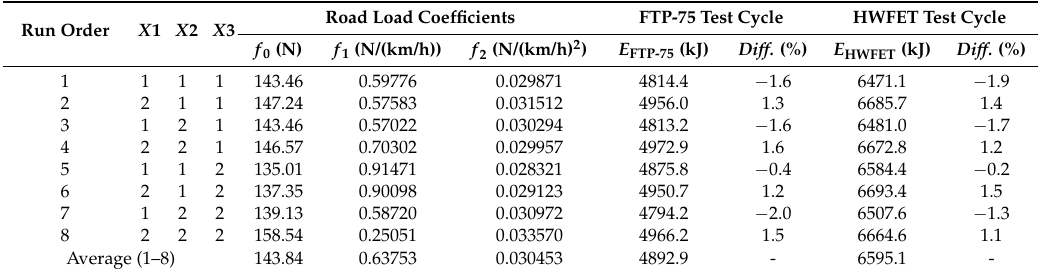
Table 8. Results of the road load correlation test program, corresponding to data as represented in Figure 4. Diff.: difference.